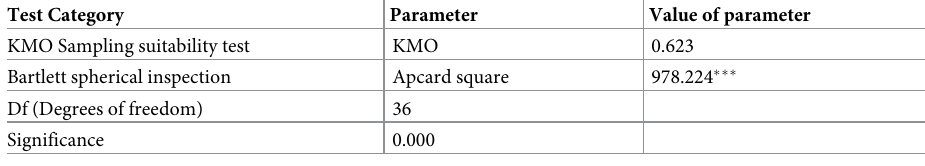
Table 2. KMO inspection and Bartlett